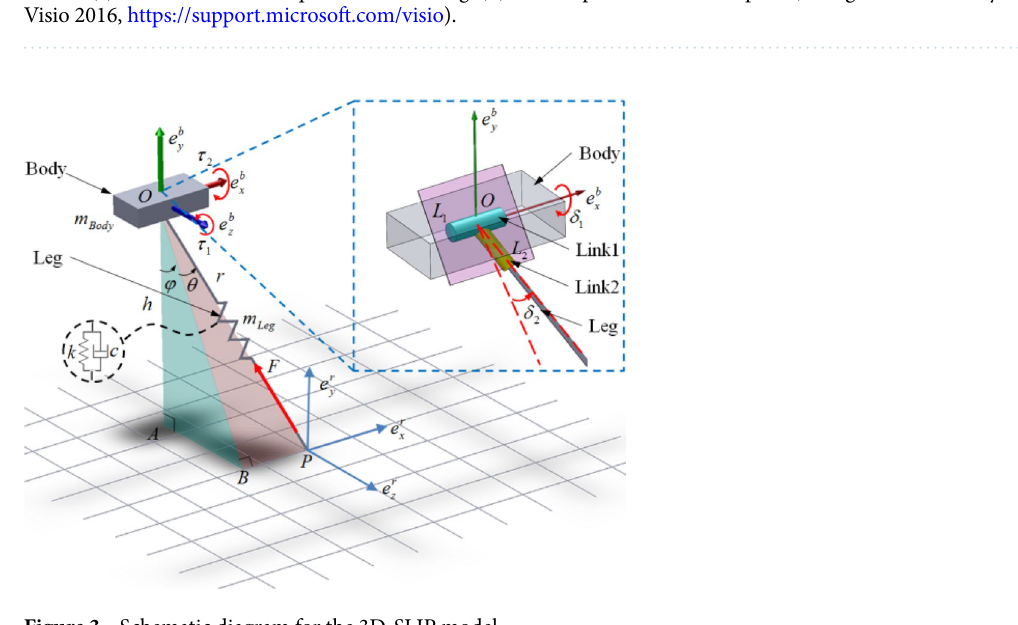
Figure 3. Schematic diagram for the 3D-SLIP